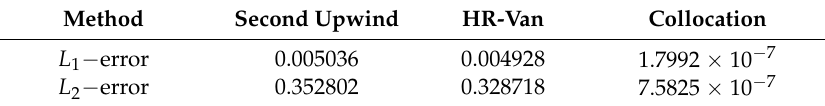
Figure 4. Comparison for final CSD with analytical and numerical results: ( a ) in the whole crystal; ( b ) zoomed figure. Table 3. L 1 and L 2 errors for different numerical schemes.